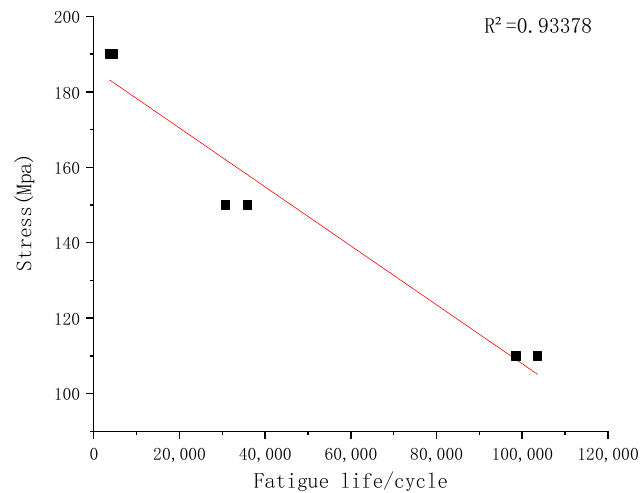
Figure 13. S-N Curve of welded joints of dissimilar lightweight materials welded joints.